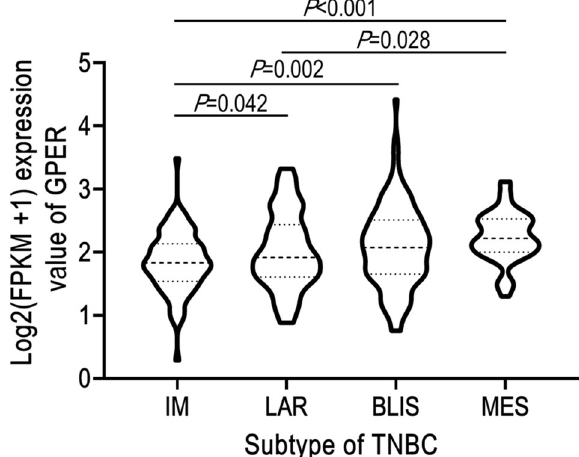
Fig. 2 Violin diagram showing the distribution of GPER expres- sion among subtypes of TNBC. Statistically signi fi cant differences were de fi ned as P < 0.05. Abbreviations: IM immunomodulatory subtype; LAR luminal androgen receptor subtype; BILS basal-like immune-suppressed subtype; MES mesenchymal-like